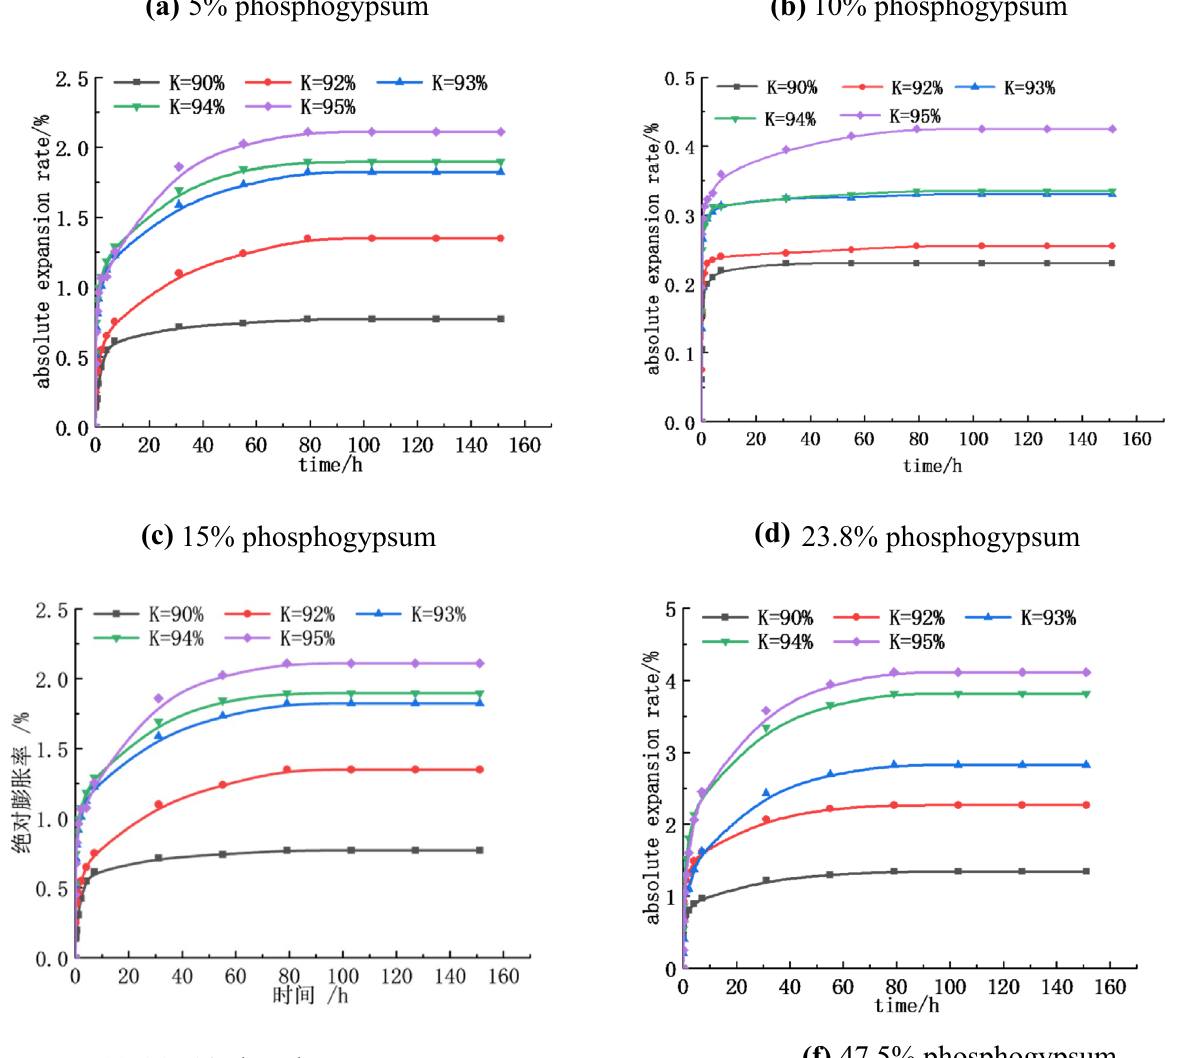
Fig. 5 Relationship between absolute expansion rate of mixture and time (5%